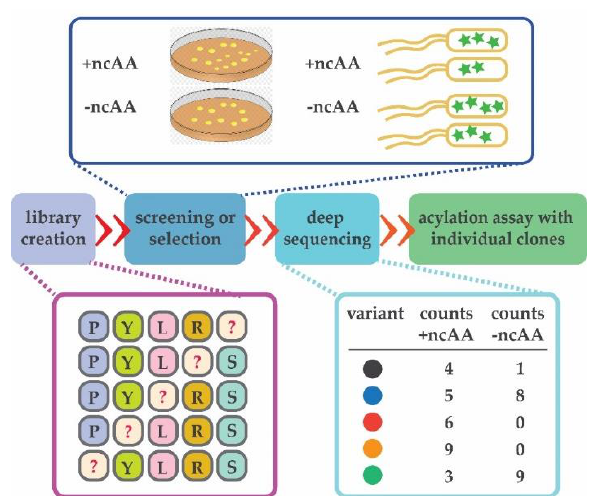
Figure 4. Deep mutational scanning is invaluable for the entire process of directed evolution. It can be used to inspect the quality of the initial aaRS library and quickly identify variants selective for the ncAA. Deep sequencing may be used to ensure even distribution of generated variants after mutagenesis (in purple). After screening or selection is executed in the presence and absence of an ncAA (dark blue rectangle), entire populations of cells are collected and DNA isolated. Individual variants are counted in the populations collected from both selections (light blue rectangle). Variants observed in the populations selected in the presence of ncAA can be then directly tested in an aminoacylation assay in vitro (green). Randomized positions are depicted with